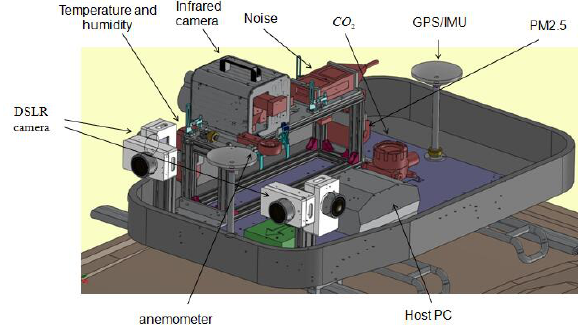
Figure 1. Environmental monitoring